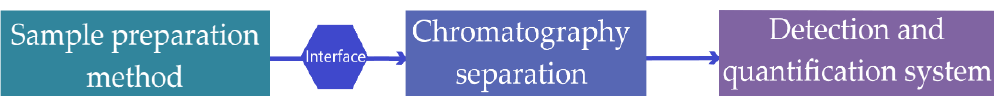
Figure 6. Schematic diagram representing a typical workflow employed in fully automated Extraction-Chromatography-Mass Spectrometry